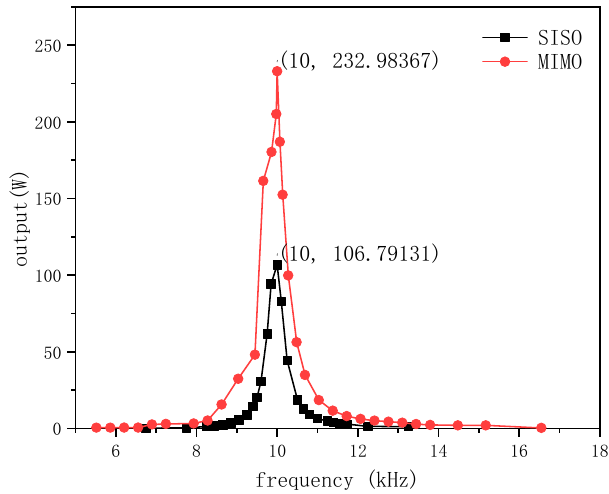
Figure 15. SISO and MIMO output power experimental results. The resonance frequency is 10 kHz, output power of the SISO system is 106.79 W, and transmission efficiency is 94.6%. The output power of the MIMO system is 232.98 W. The transmission efficiency is 92.2%. It can be observed from the comparison experiment that the output power of the MIMO system is 2.18 times that of the SISO system under the same power supply and physical size of the magnetic coupling structure. To verify the high reliability of the MIMO system, the coil of the secondary-side cir- cuit 1 is disconnected. Because the experimental circuit is connected according to the equivalent circuit in Figure 6, the load will no longer be powered by two sets of power supplies after the secondary side coil is disconnected, and the equivalent load becomes 1/2 of the original. The output power during the fault and regular operation with different loads is pre- sented in Table 4. It can be observed that the output power fluctuates within 1% before and after the fault. Therefore, when the secondary side coil is disconnected, the output power of the secondary side of the MIMO supports each other such that the output power is unchanged. Table 4. Output power of different loads in the normal operating state and after secondary side coil failure.